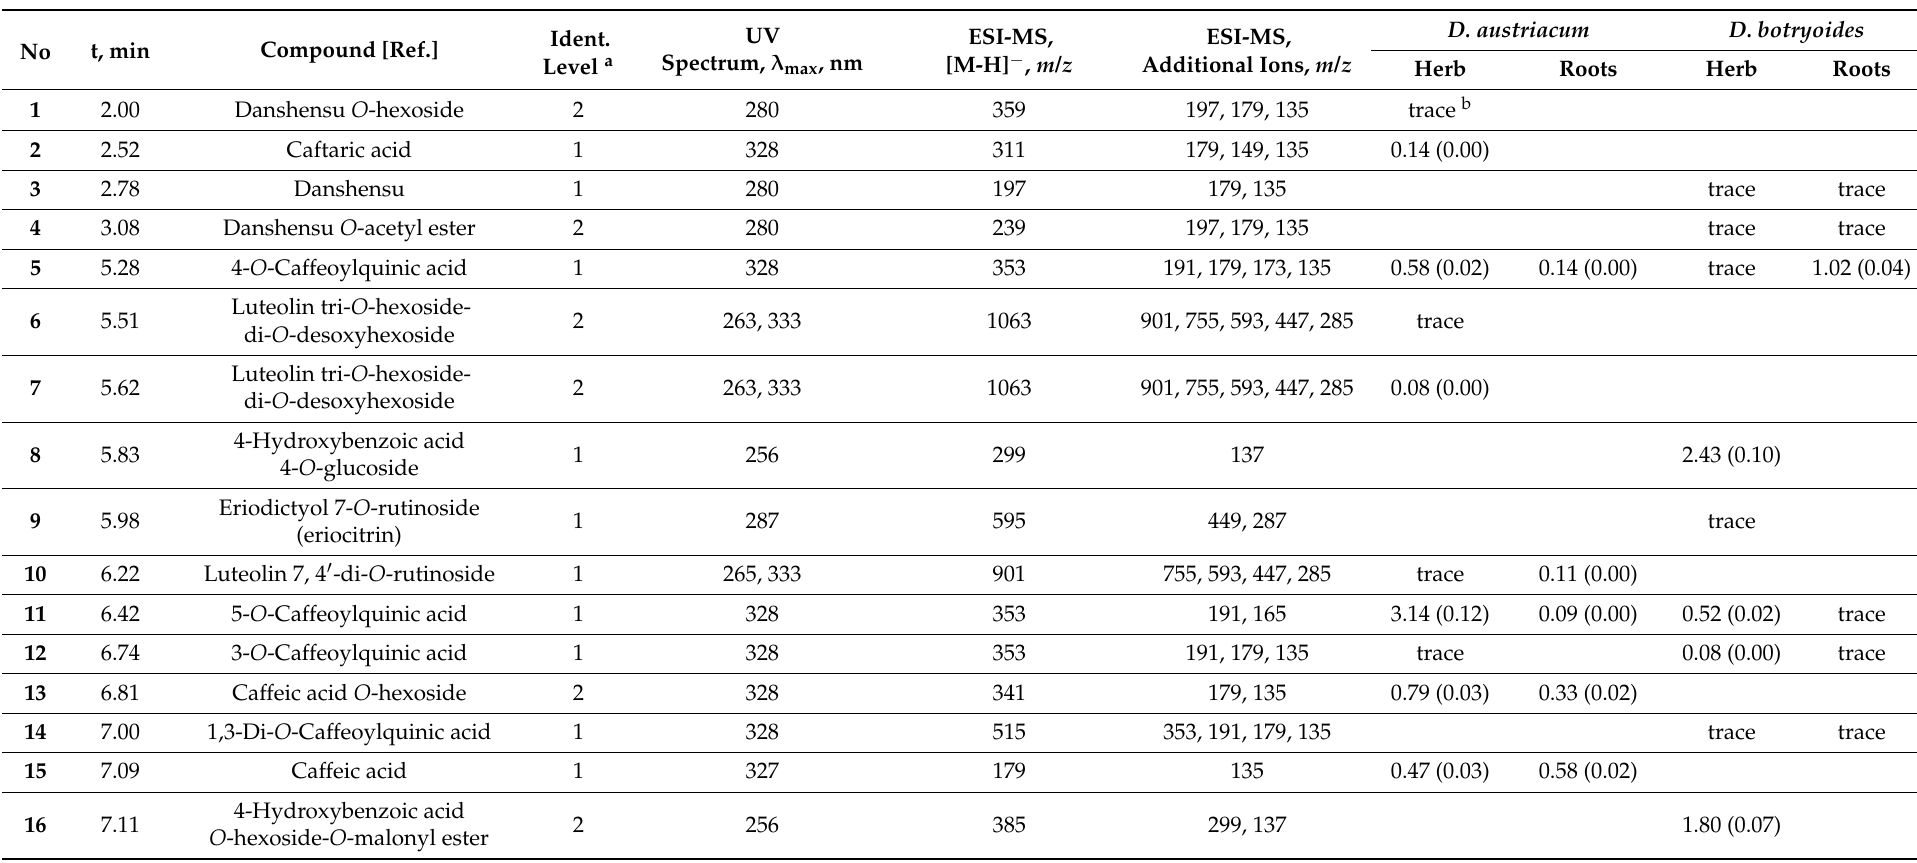
Table 1. Retention times (t), ultraviolet (UV), and mass spectral (ESI-MS) data of compounds 1 – 50 were found in leaves and roots of D. austriacum and D. botryoides , in addition to their content (mg/g of dry plant weight, in brackets